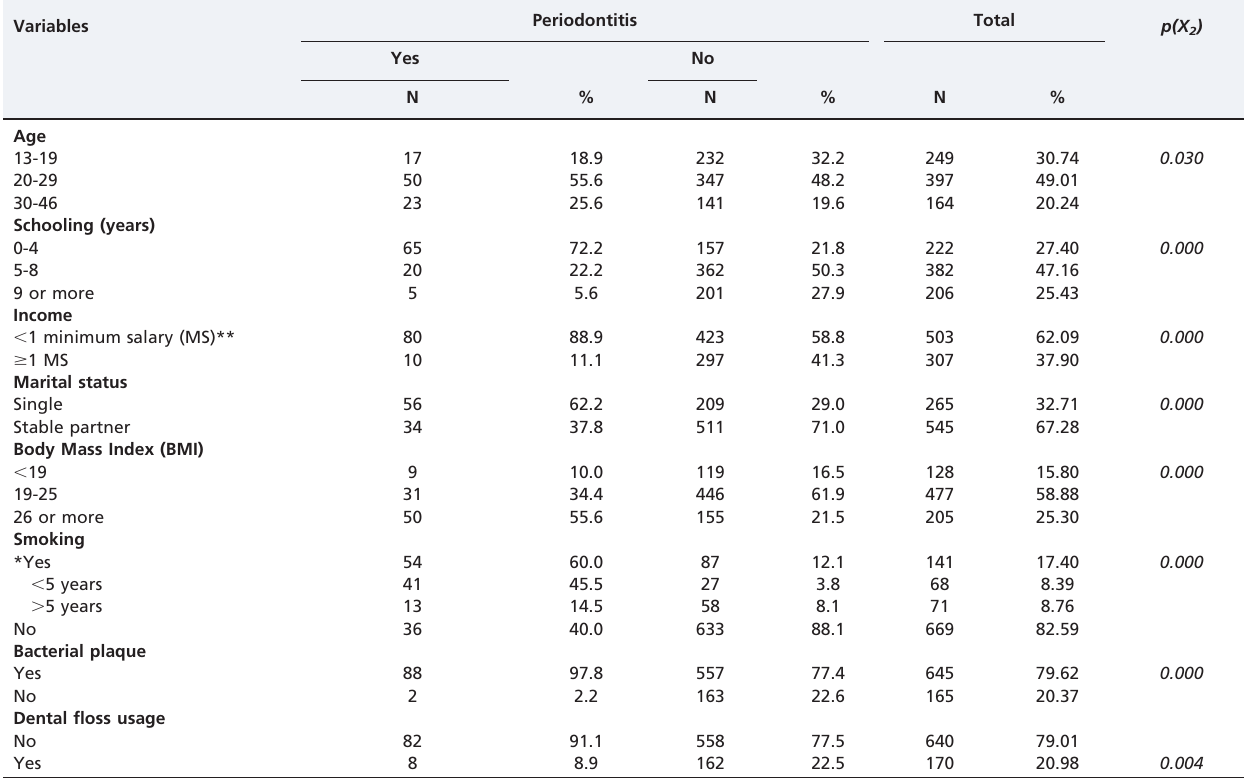
Table 1 - General characteristics of participants with and without periodontitis from Recife, Brazil, 2008.